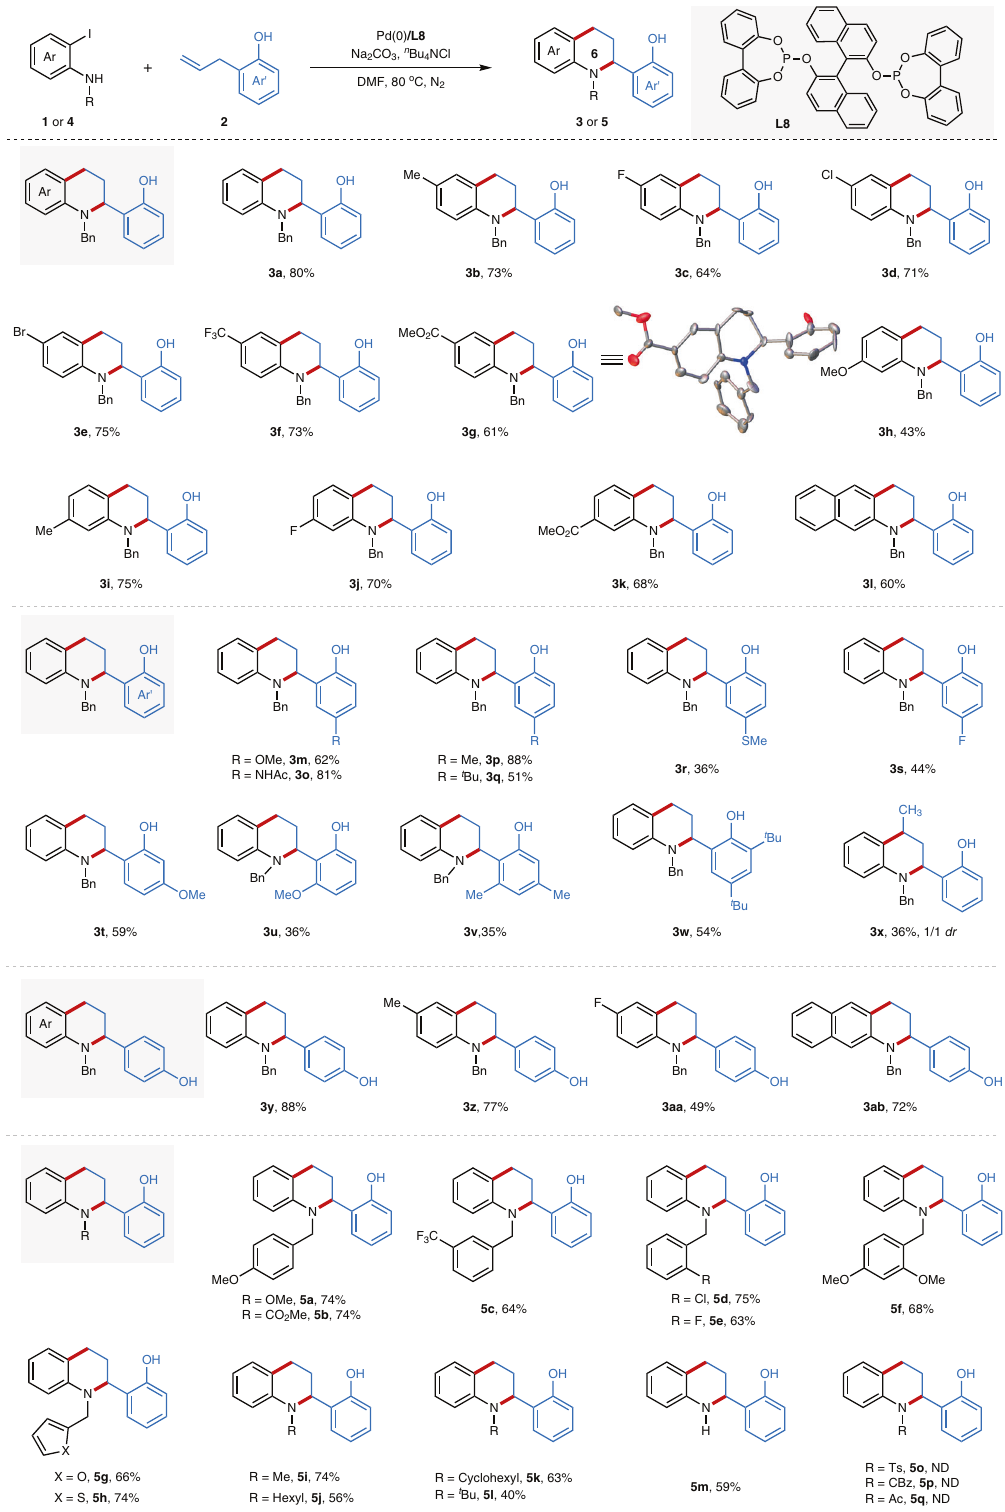
Fig. 4 | The synthesis of tetrahydroquinoline derivatives via Pd-catalyzed migratory cycloannulation. The values under each structure indicate isolated yields (See Supplementary Information for experimental details). Reaction con- ditions: 1 (0.4mmol), 2 (0.2mmol), Pd 2 (dba) 3 (2.8mg, 1.5mol%), L8 (4.3mg, 3.0mol%), Na 2 CO 3 (53.0mg, 0.5mmol), n Bu 4 NCl (111.2mg, 0.4mmol), DMF